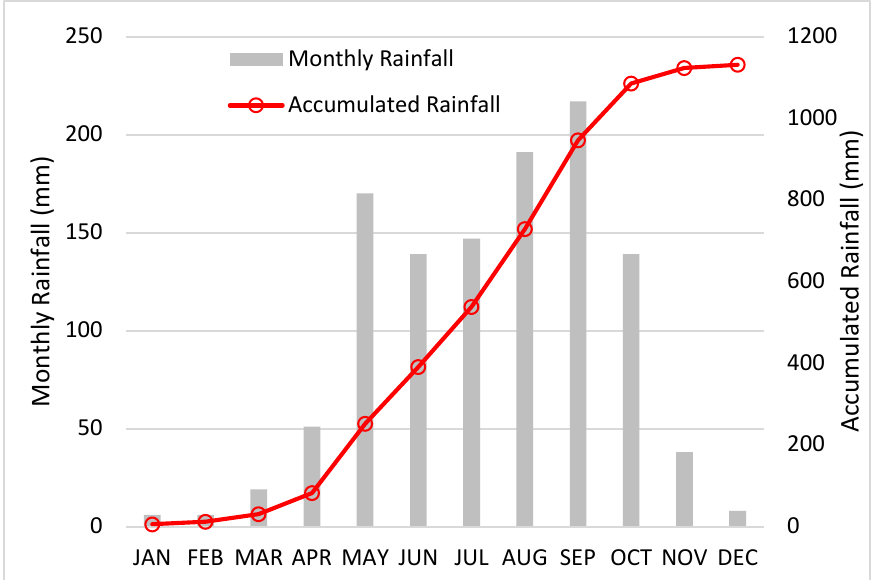
Figure 2. Monthly and accumulated rainfall in the Ping River Basin.